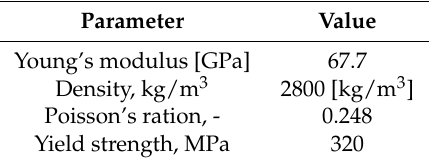
Table 10. Aluminum 2024—material properties.